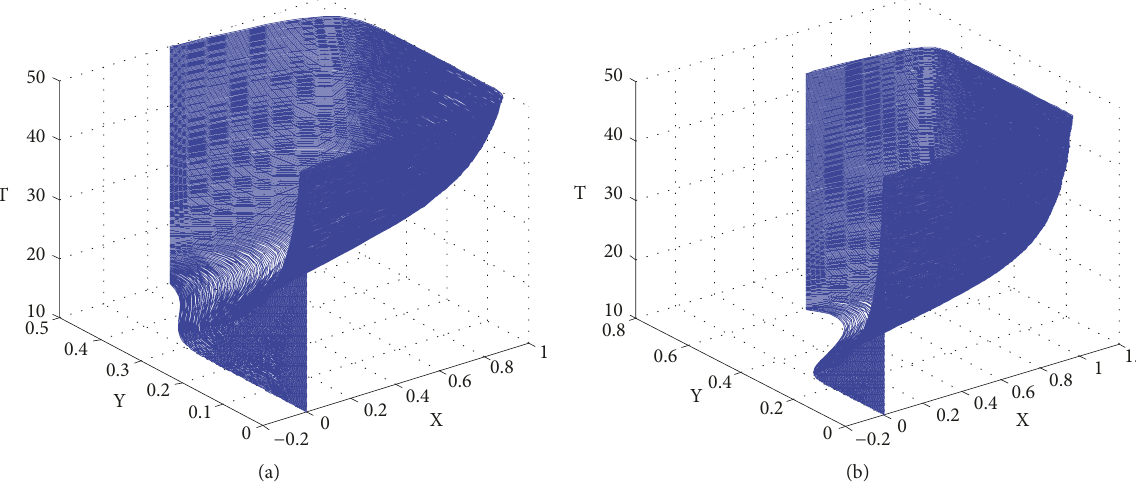
Figure 17: The change of 𝑇 with respect to the initial values of (0.4,0.6) and (0.3,0.5) in Scenario